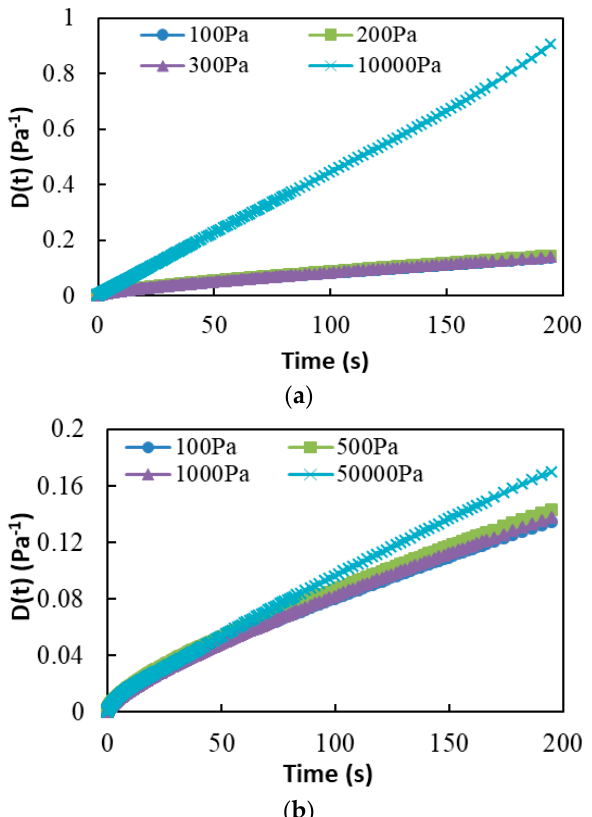
Figure 3. Measured creep compliance of the CSR test. ( a ) Base binder at 35 °C; ( b ) SBS modified binder at 35 °C.